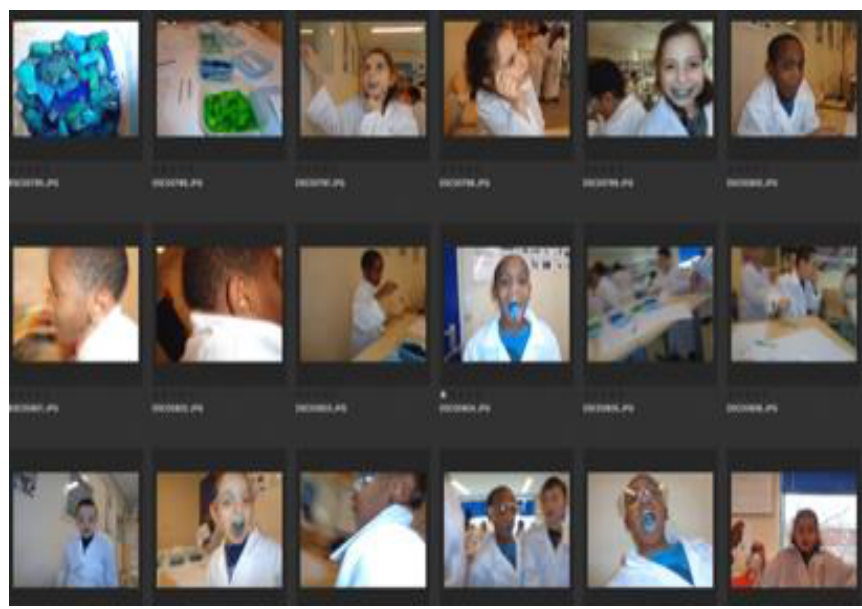
Figure 3. Selfies of blue tongues at the end of the food lab.